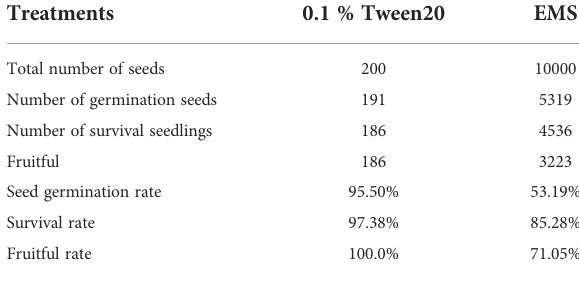
TABLE 2 The germination and survival rate of the M1 generation.